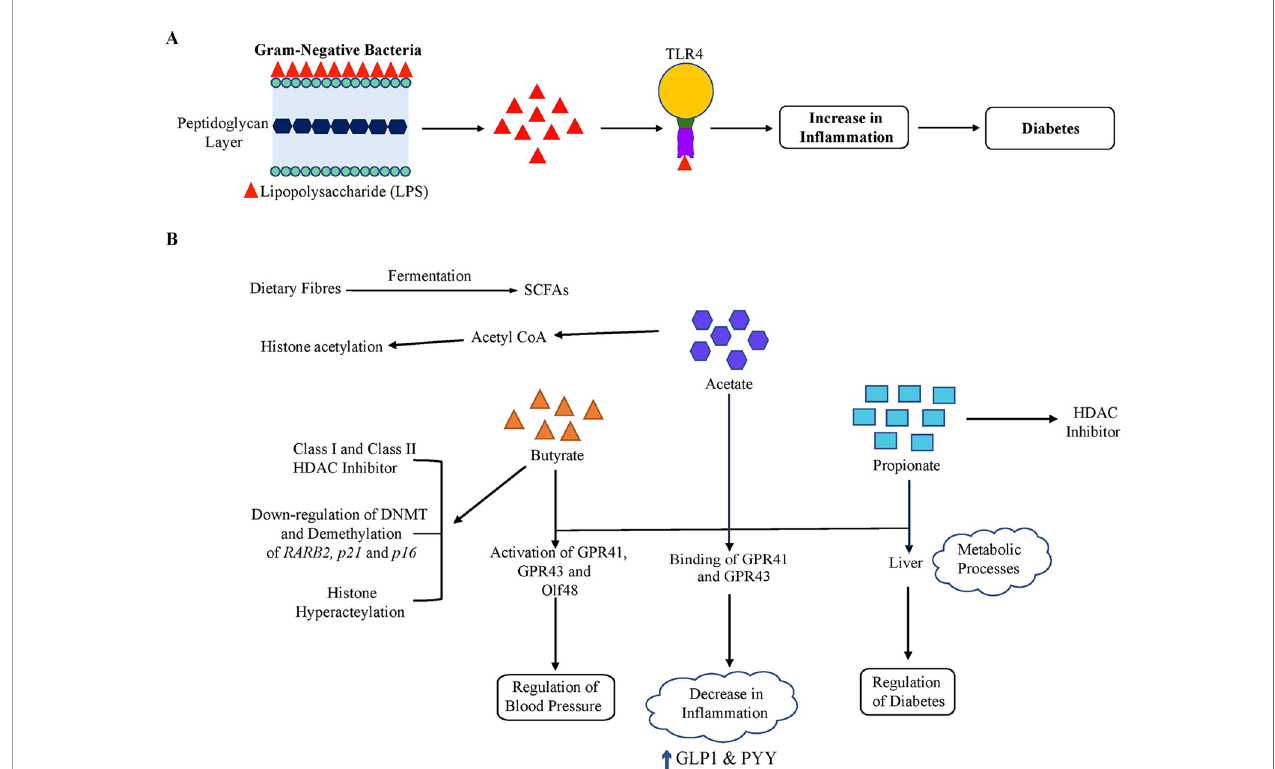
FIGURE 3 | Gut microbiome and host metabolism. The gut microbiome may alter host metabolism through many mechanisms. Of these, two important mechanisms are illustrated. (A) Lipopolysaccharide (LPS). LPS originates from the outer membrane of Gram-negative bacteria and binds to Toll-like receptor 4 (TLR4), which results in low-grade in fl ammation and thus a decline in insulin sensitivity. (B) Short-chain fatty acids (SCFA). The gut microbiota ferments dietary fi bers to SCFAs, including acetate, butyrate, and propionate. Acetate and propionate participate in essential metabolic processes such as gluconeogenesis and lipogenesis in the liver. In addition, SCFAs bind to the G protein-coupled receptors GPR41 and GPR43 resulting in various effects depending on the cellular types affected. In immune cells, this signaling led to a decrease in the in fl ammation and resulted in an increase in GLP1 and PYY levels in enteroendocrine L-cells, which improve insulin sensitivity overall. Also, these SCFAs activate GPR41, GPR43, and Olfr78 expressed in the kidney. Olfr78 induces SCFA-mediated release of renin which leads to rise in blood pressure. On the other hand, GPR43 resists this change in blood pressure by vasodilatory action. SCFAs are involved in the induction of epigenetic alterations. Butyrate is a known class I and class II HDAC inhibitor. Butyrate can also affect DNA methylation and demethylation of some tumor suppressor genes ( RARB2, p21, and p16 ) and is involved in acetylation of histone H3. Propionate is also a contributor to HDAC inhibition. In addition, acetate has been found to be involved in increasing histone acetylation via transferring an acetyl group from